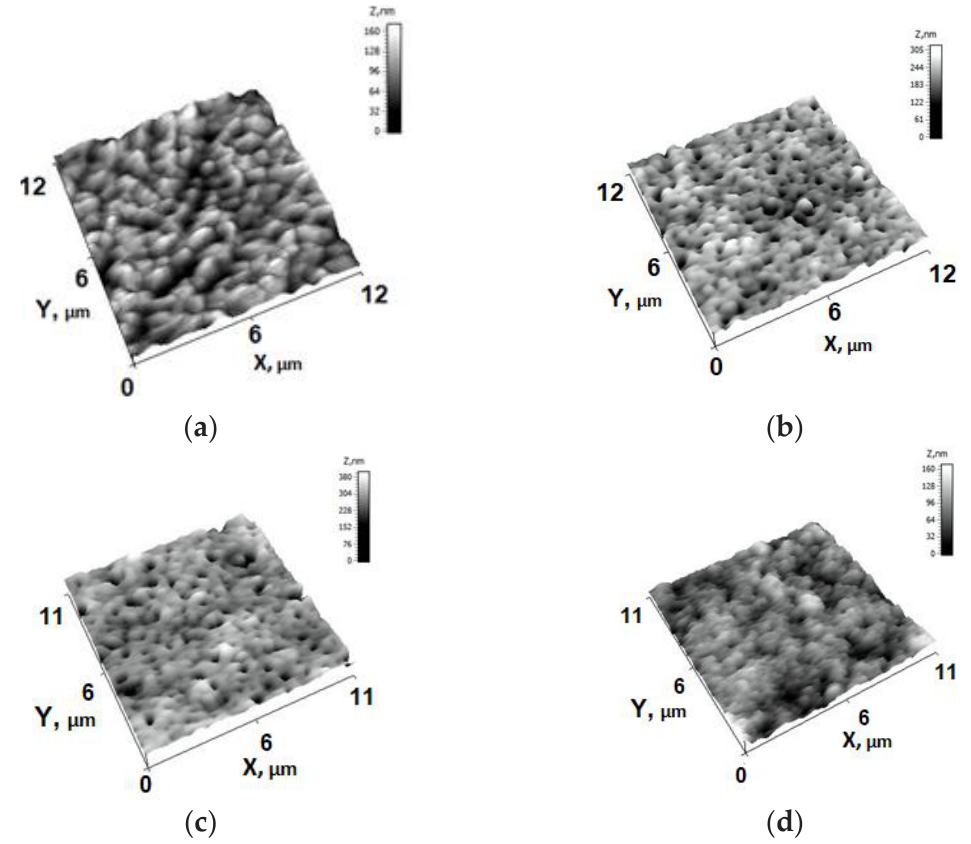
Figure 5. AFM micrographs of skin layer of initial PSf-membrane M 0 ( a ) and membranes modified with PTFE-layer thickness 45 nm (M 1 ) ( b ), 660 nm (M 2 ) ( c ), and 1350 nm (M 3 ) ( d ). Table 2. Surface roughness parameters and water contact angles of membranes.